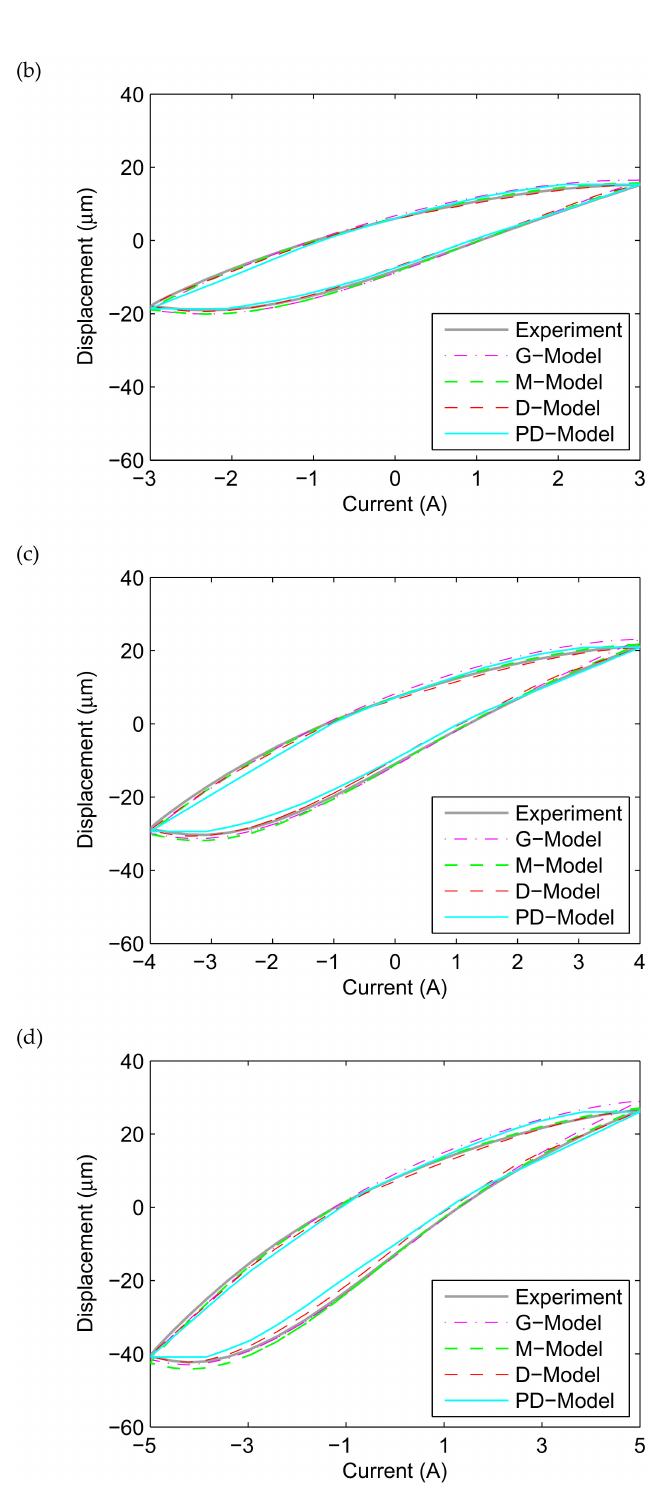
Figure 8. Comparison of the experimental data and the fitted results of the established ISSF-Duhem model and the PD-Model when the magnetostrictive actuator under 1 Hz harmonic input with di ff erent currents: ( a ) 2 A, ( b ) 3 A, ( c ) 4 A, and ( d ) 5 A. G-Model: the ISSF-Duhem model with Grompertz function-based shape function; M-Model: the ISSF-Duhem model with modified hyperbolic tangent function-based shape function; D-Model: the ISSF-Duhem model with a one-sided dead-zone operator-based shape function; PD-Model: the modified Prandtl–Ishlinskii model with a one-sided dead-zone